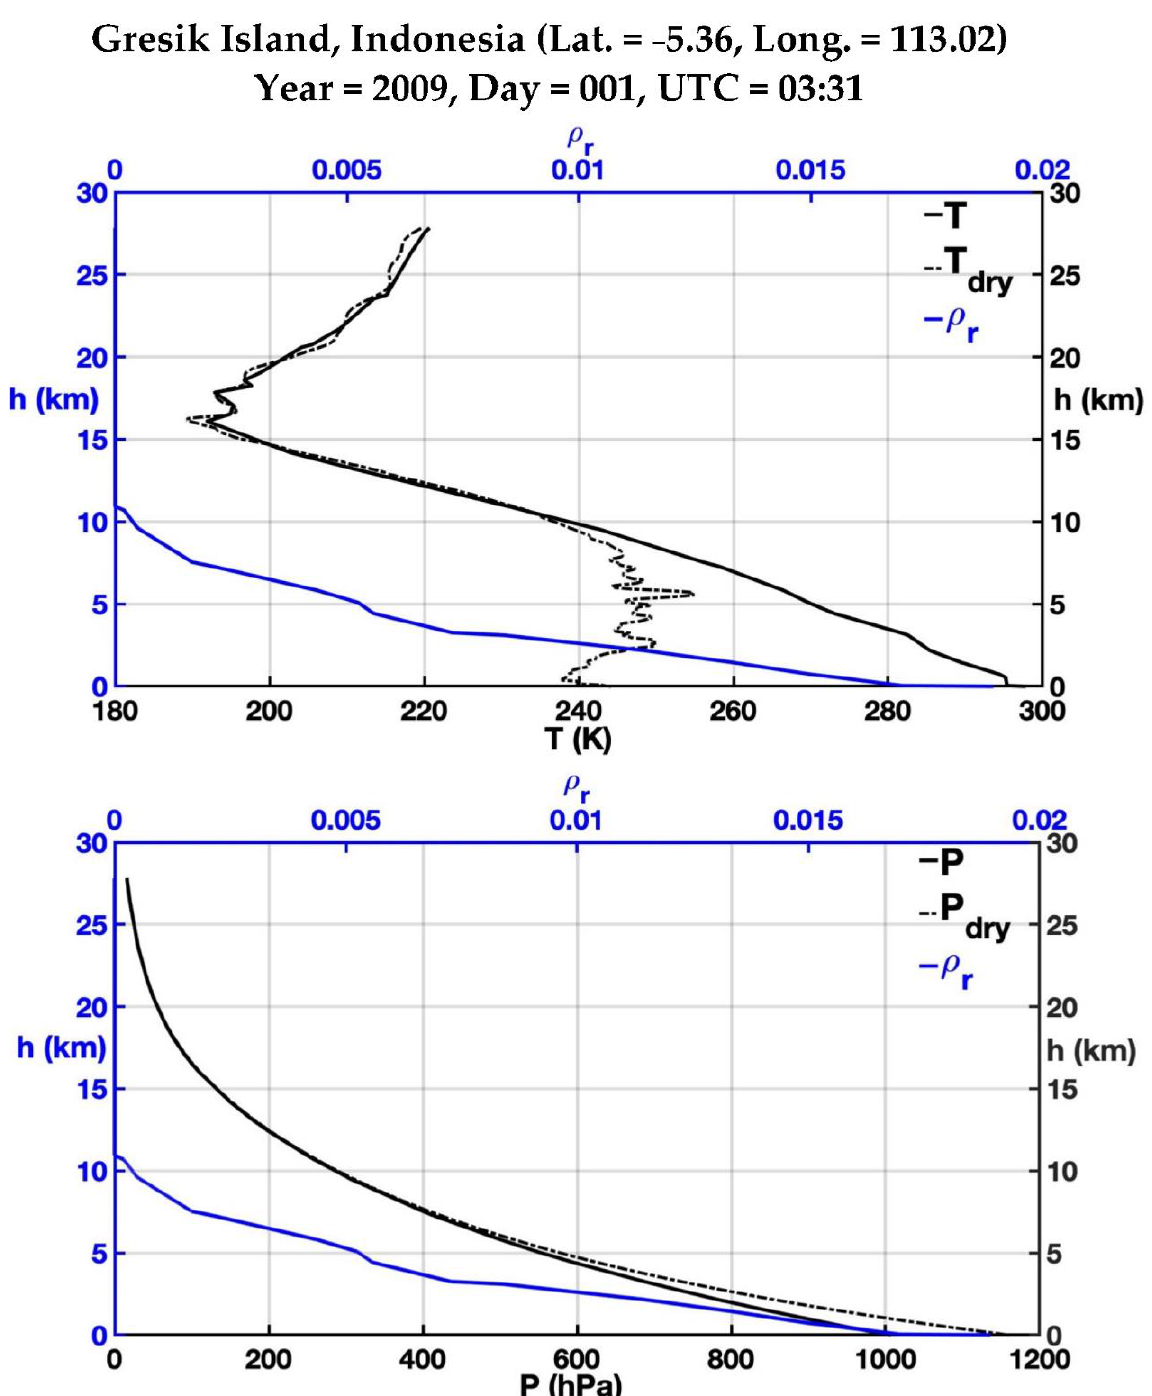
Figure 2. Vertical profiles of real temperature T and dry temperature T dry ( top ), and real pressure P and dry pressure P dry ( bottom ), together with mixing ratio (cid:36) r for a RO taking place at Gresik Island, Indonesia, on 1 January 2009.